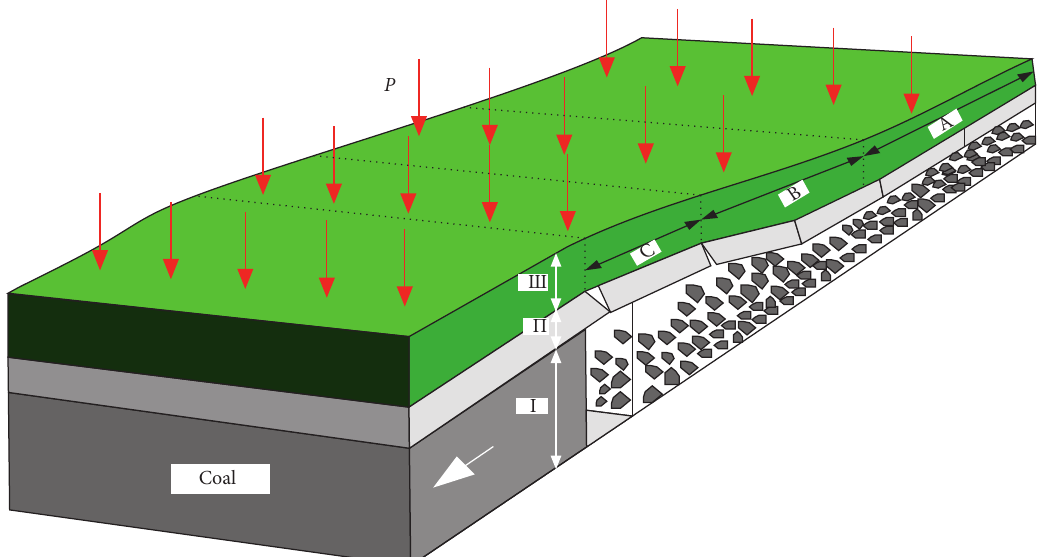
Figure 1: Three-dimensional distribution of overburden in gob. (A) recompaction area; (B) coal rock separation area; (C) coal wall support area; (I) caving zone; (II) fracture zone; (III) bending zone.